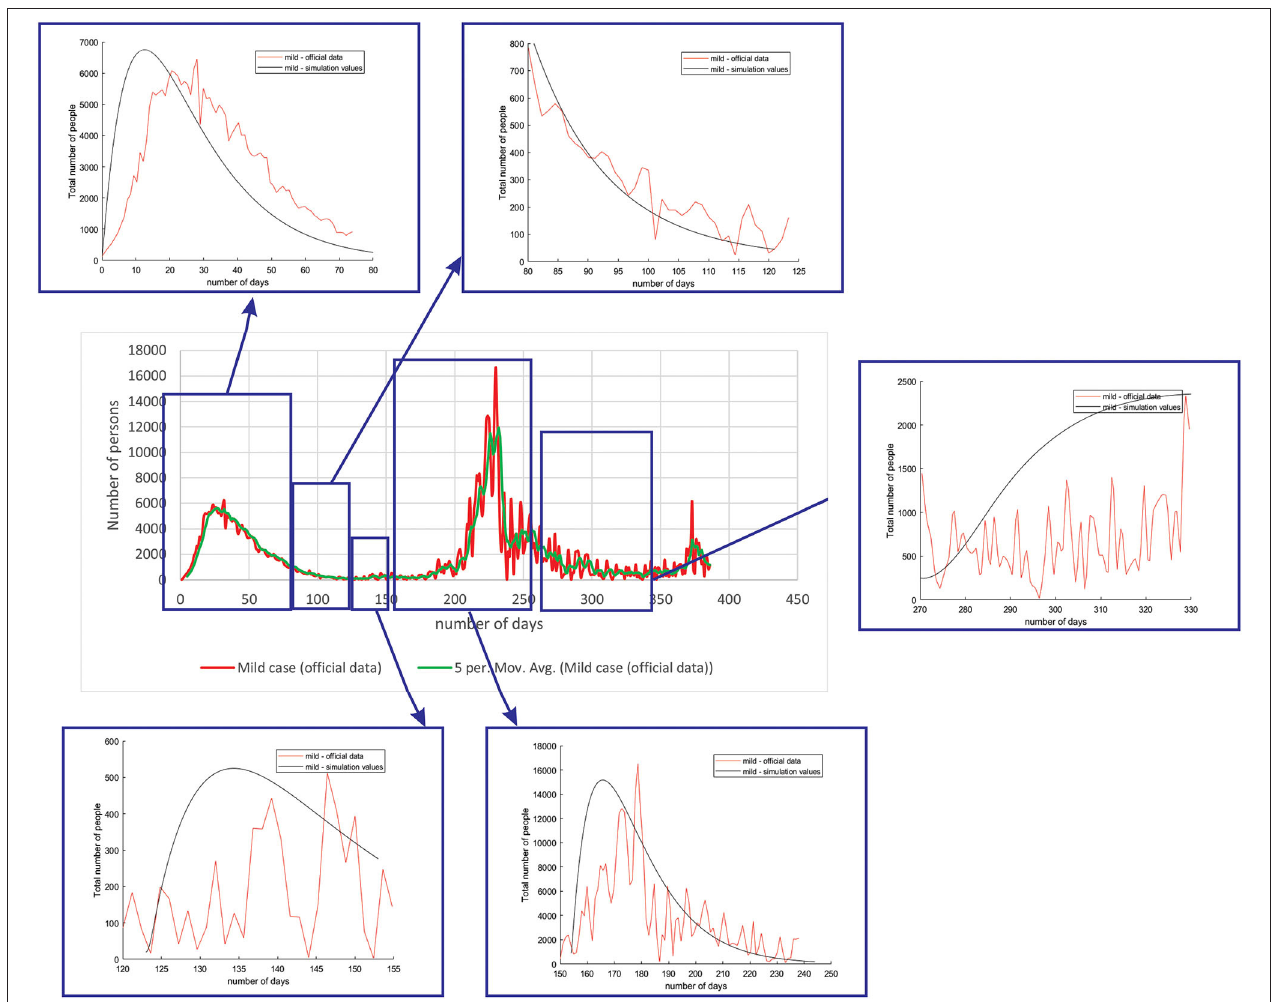
FIGURE 4 | Comparison between the real and simulated values for mild cases in Belgium using the proposed SEIRD